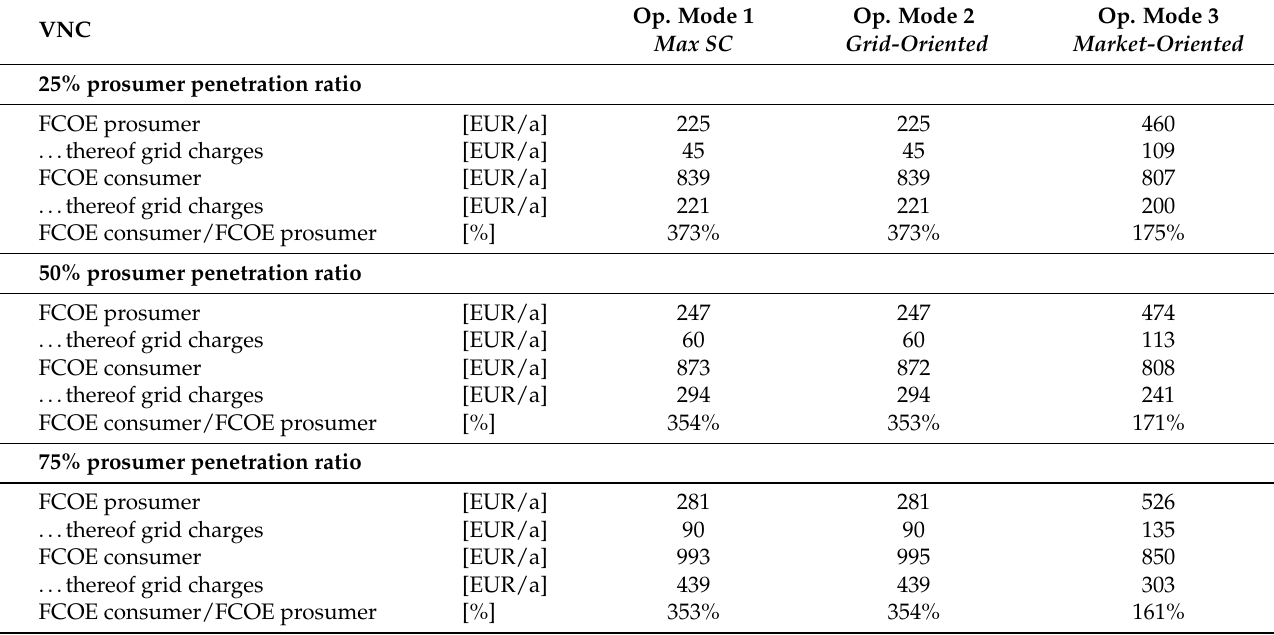
Table 6. Summary of end customer effects for volumetric grid charges.